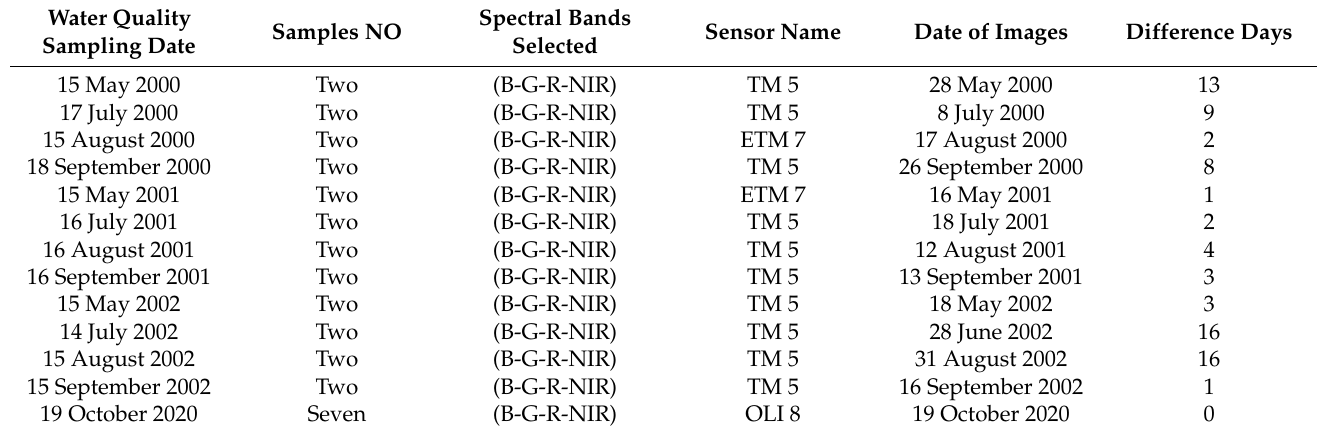
Table 1. Landsat images selected, based on measured field